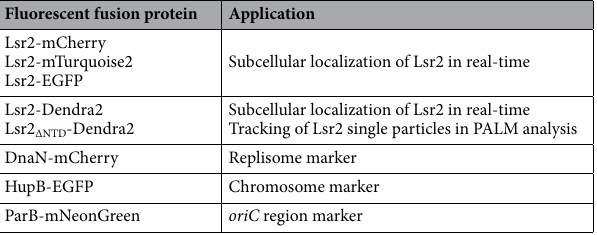
Table 1. Fluorescent fusion proteins used in this study (for more details see Table